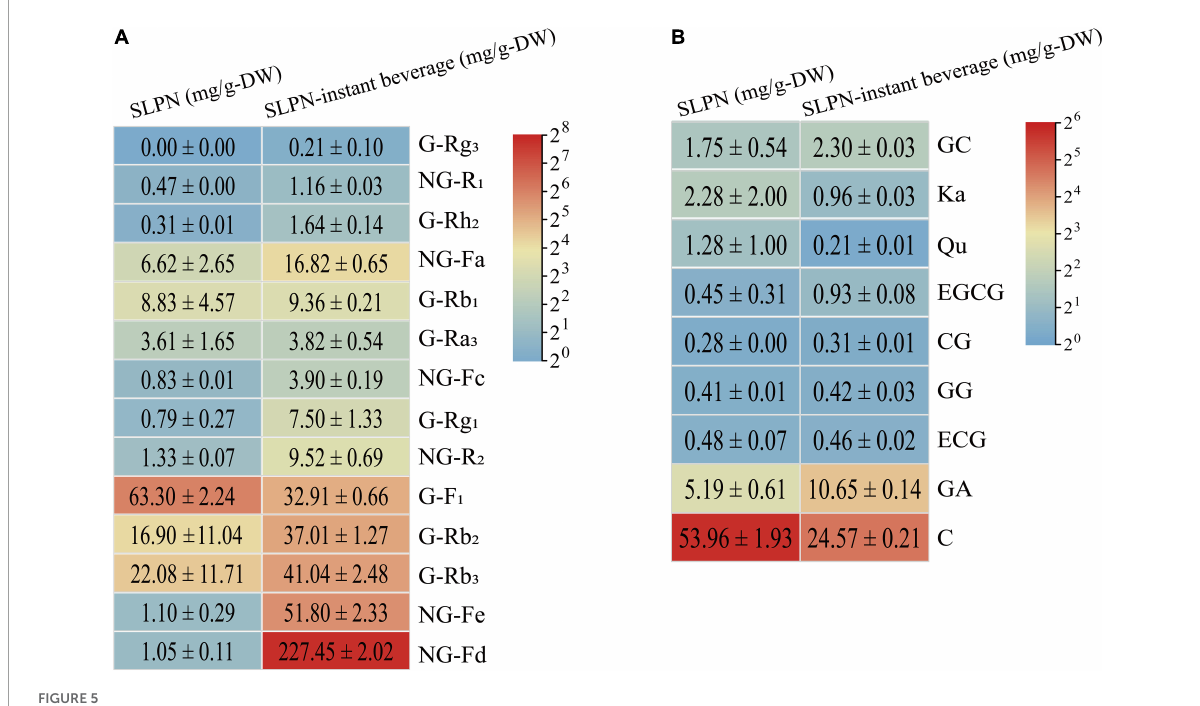
( B ) 1:15–1:20, extraction time ( C ) 36 h, the highest point of the extraction rate in 3D hook face reached